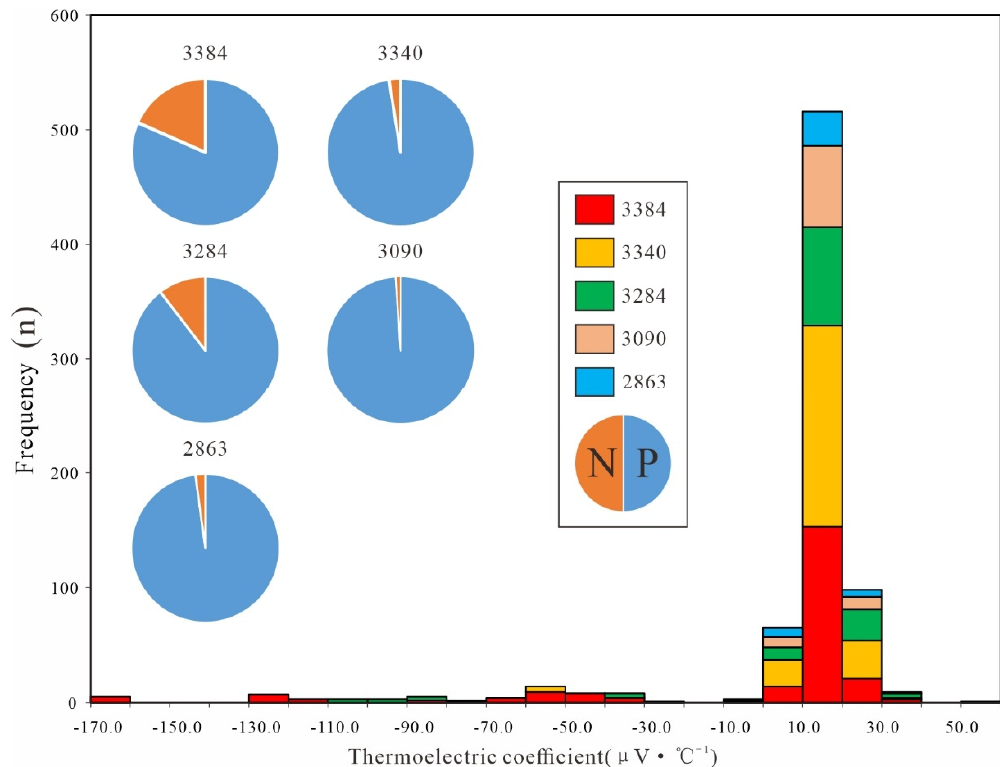
Figure 14. Thermoelectric characteristics of pyrite.